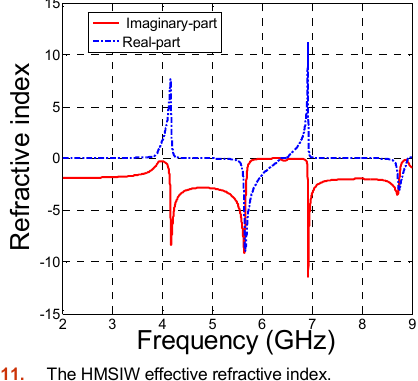
FIGURE 11. The HMSIW effective refractive index.